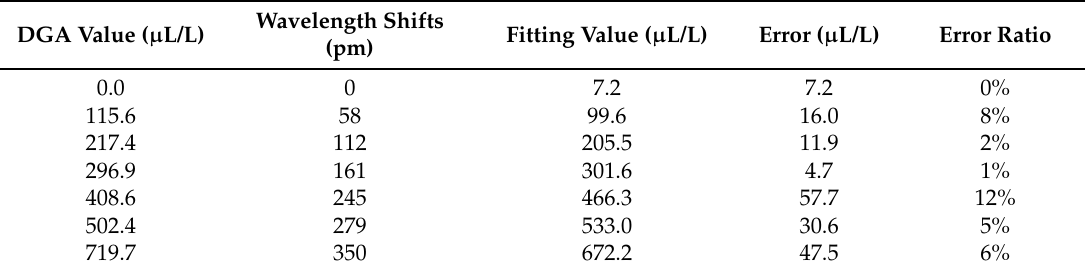
Table 1. Results analysis of measurement in oil